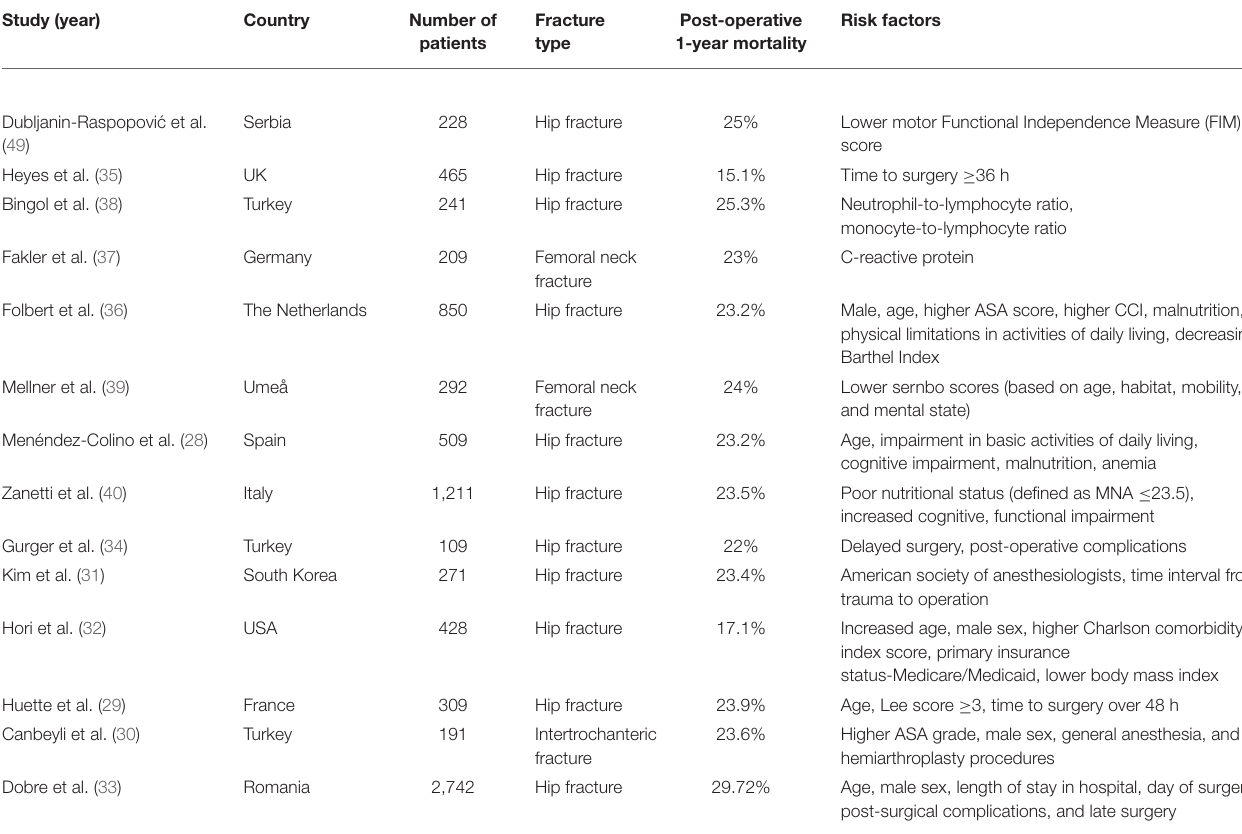
TABLE 5 | The risk factors of post-operative 1-year mortality in hip fracture patients in previous